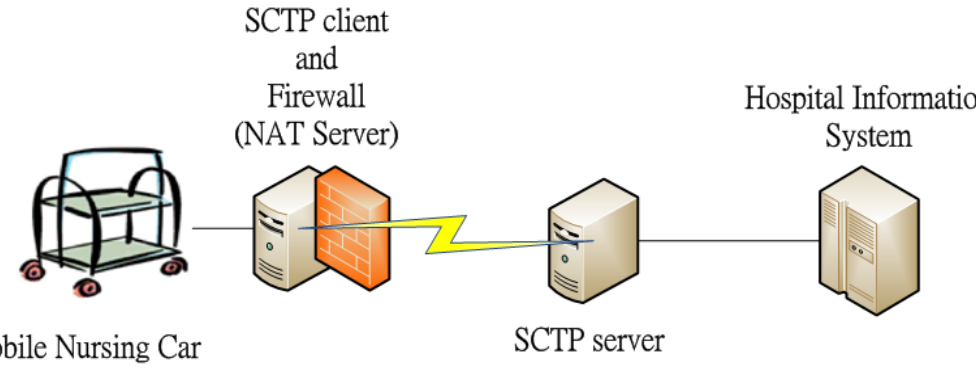
Figure 1. Deployment diagram of the SCTP-Tunnel